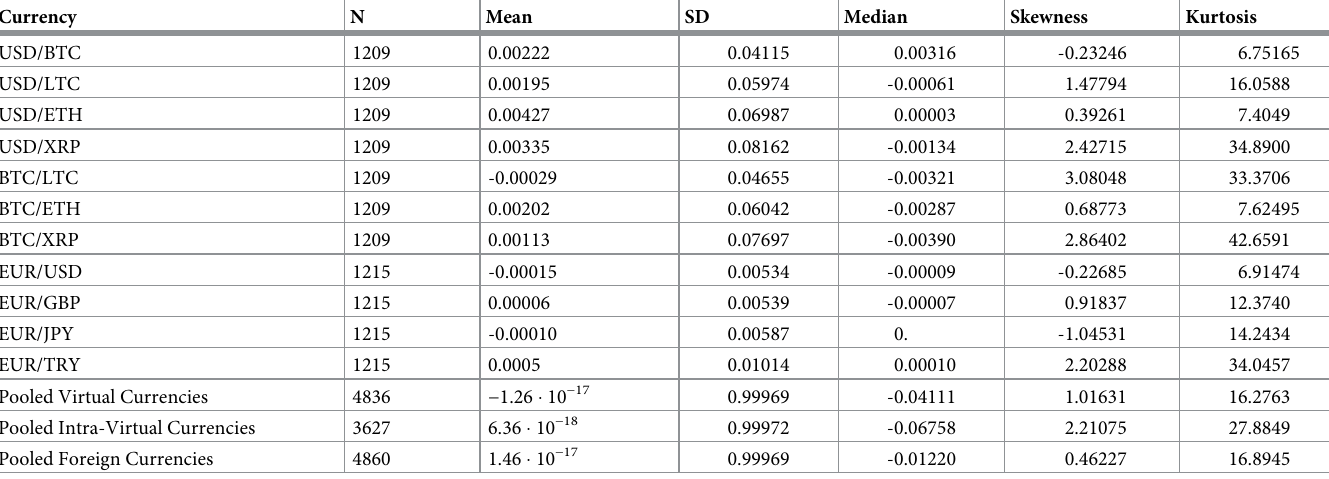
Table 2. Descriptive statistics of virtual, intra-virtual and foreign exchange